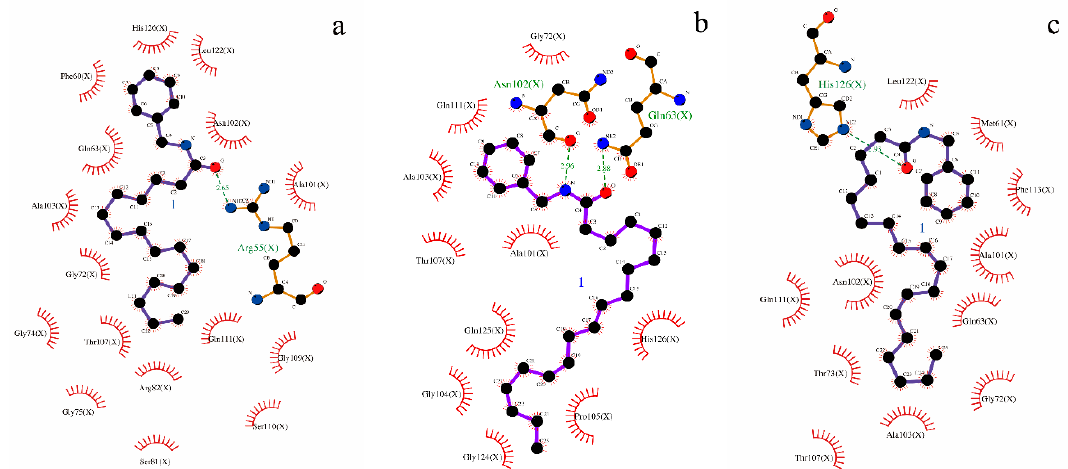
Figure 7. ( a – c ) Molecular docking of the three bioactive ligands with CypD, respectively. Ligands were shown in stick form and gray dashed lines were hydrogen bonds. The figure was prepared with PyMol. The interactions between bioactive ligands and binding sites were detailed in the article. (Figure 7a-( 9 ), Figure 7b-( 6 ), Figure 7c-( 2 )).